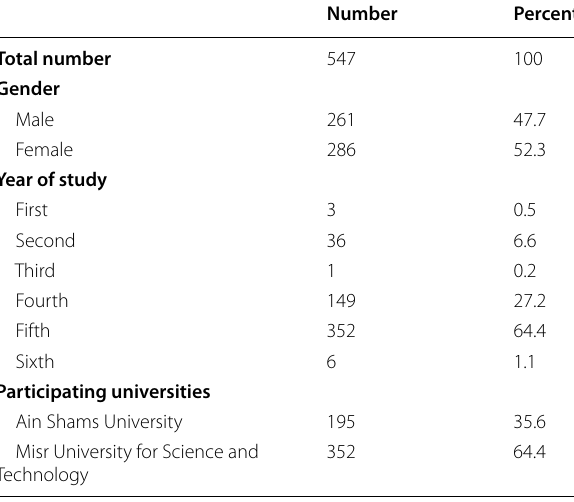
Table 1 Sample characteristics